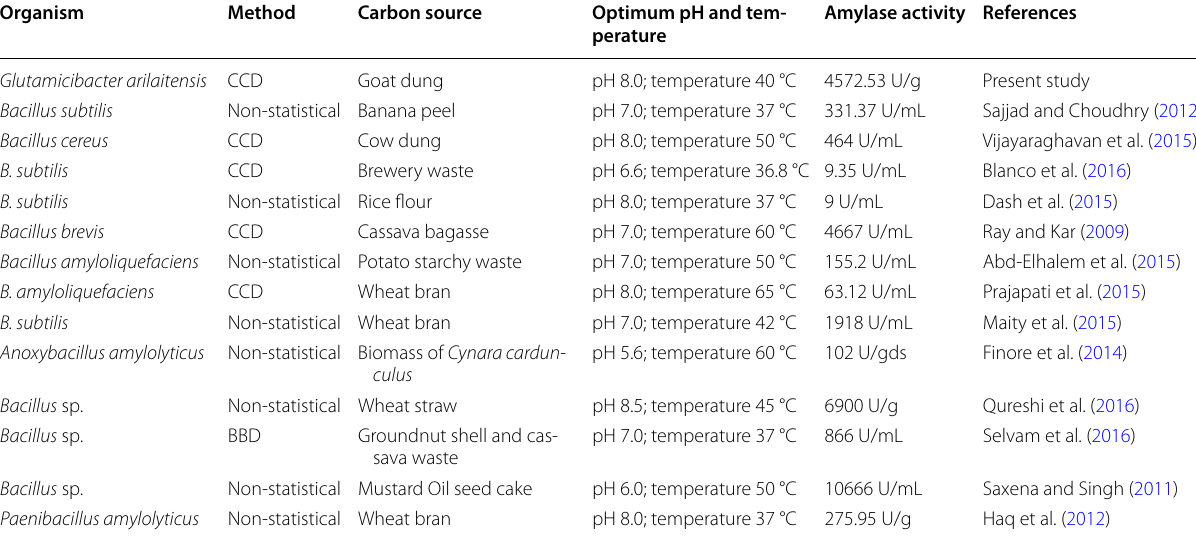
Table 7 Comparative assessment of amylase production from various bacterial species by utilizing varied agro-residues